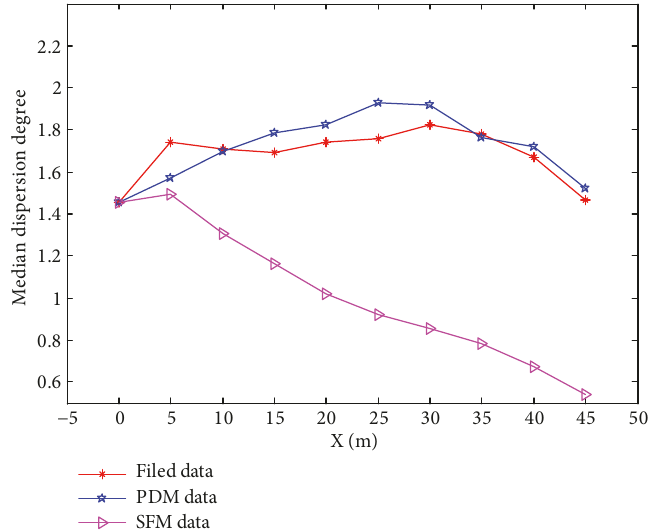
Figure 16: Median dispersion degree in each section at the Changji-Moyu intersection.